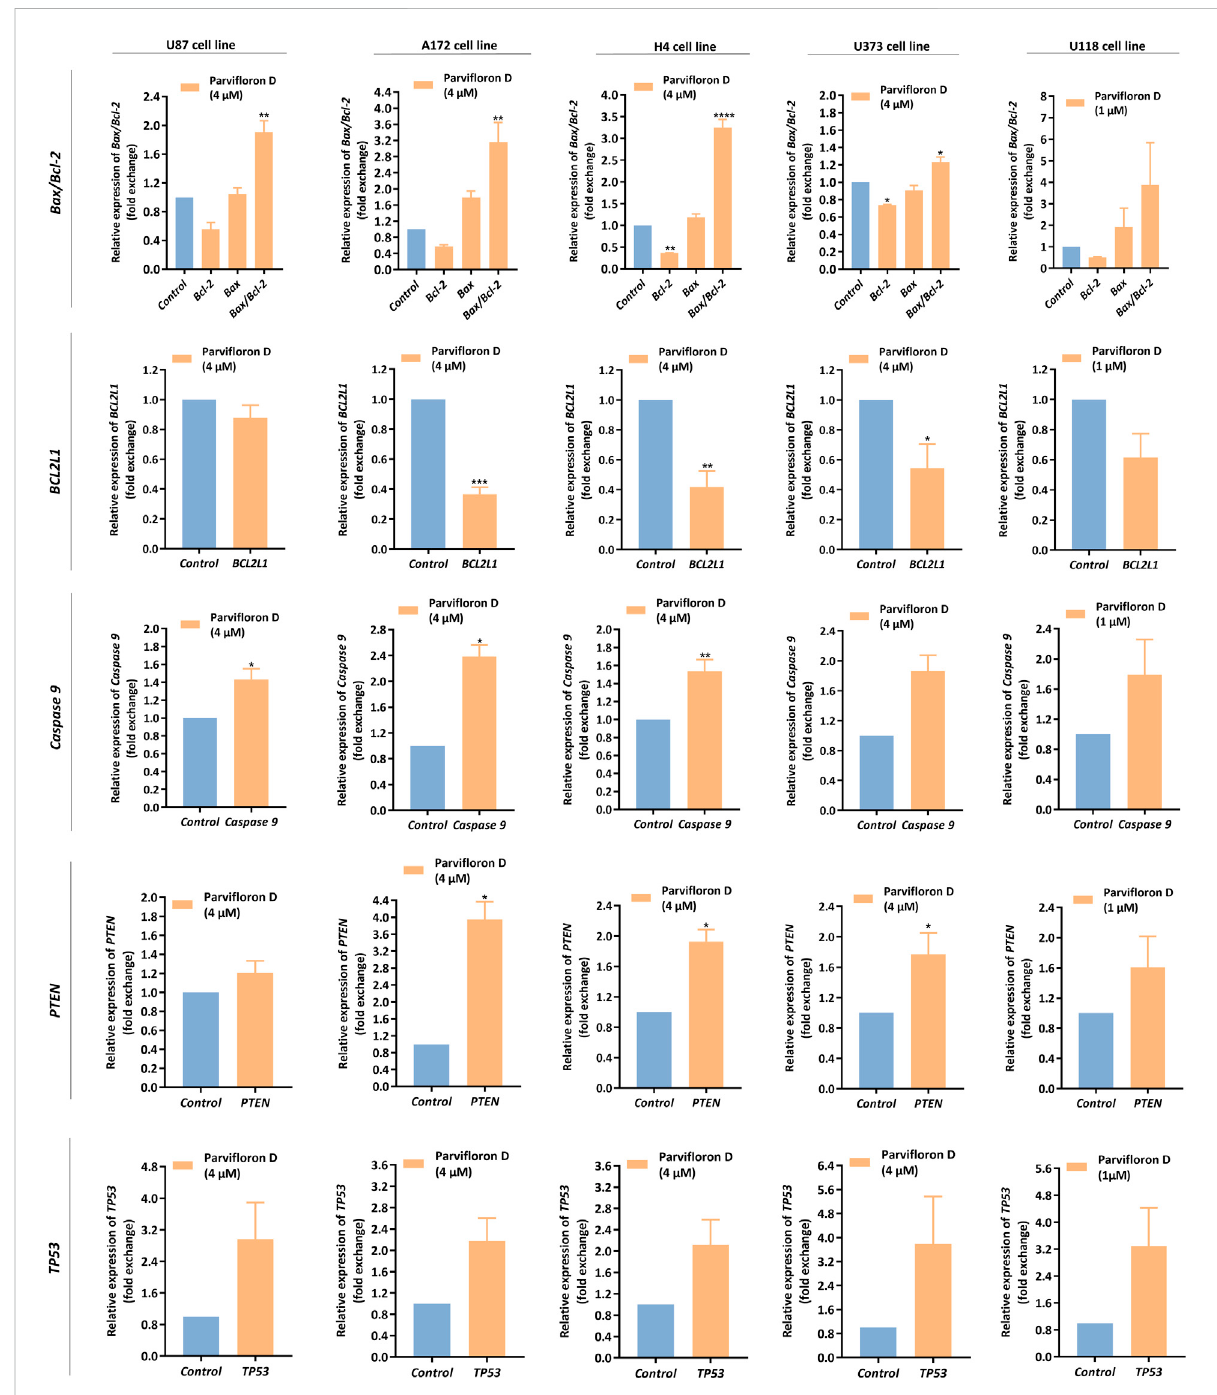
FIGURE 6 Assessmentof Bax , Bcl- 2, BCL2L1 , Caspase9 , PTEN ,and TP53 mRNAlevelsinU87,A172,H4,U373,andU118cells,afterparvi fl oronDtreatment for 48 h. After incubation, the relative expression of Bax , Bcl-2 , BCL2L1 , Caspase 9 , PTEN , and TP53 was assessed by qRT-PCR and the results normalized to GAPDH expression. Asterisks (* p < 0.05, ** p < 0.01, *** p < 0.001, and **** p < 0.0001) show the signi fi cant difference between the values obtained for treated cells relative to the control group (untreated cells). Data are presented as mean ± SD and it is representative of at least three independent